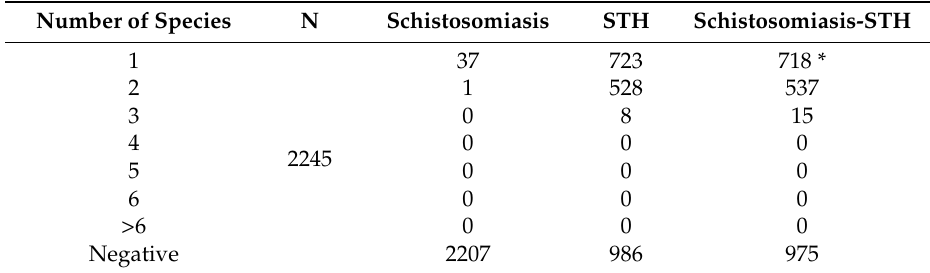
Table 2. Proportion of polyparasitism for schistosomiaisis, soil transmitted helminthiasis (STH) and combined (schistosomiais-STH). N is the total number of examined schoolchildren. Number of Species N Schistosomiasis STH Schistosomiasis-STH